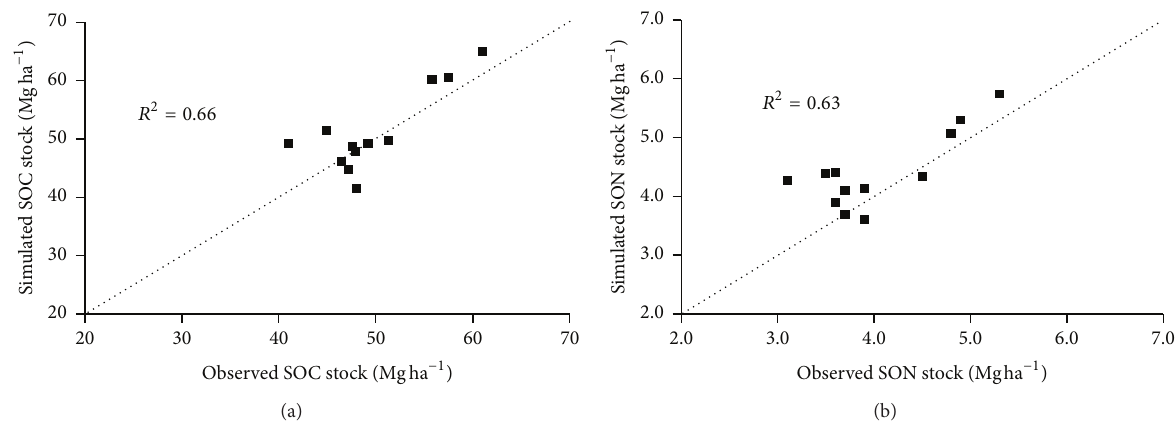
Figure 6: Comparison of observed and simulated SOC (a) and SON (b) in the T period.